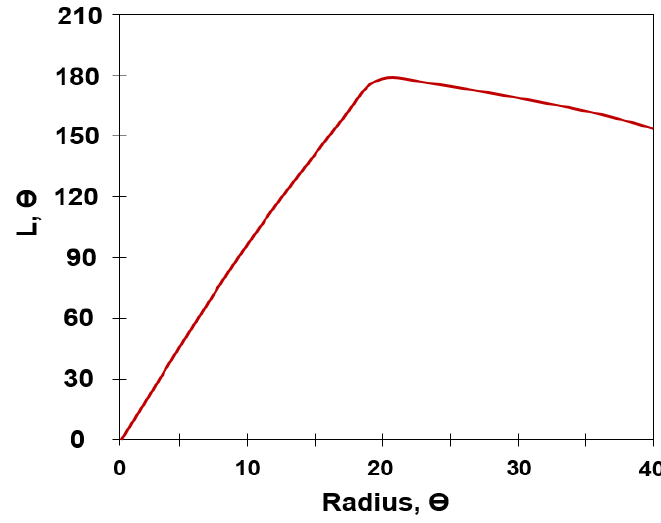
Figure 2. Relation of the angle between the radius and wire (L).